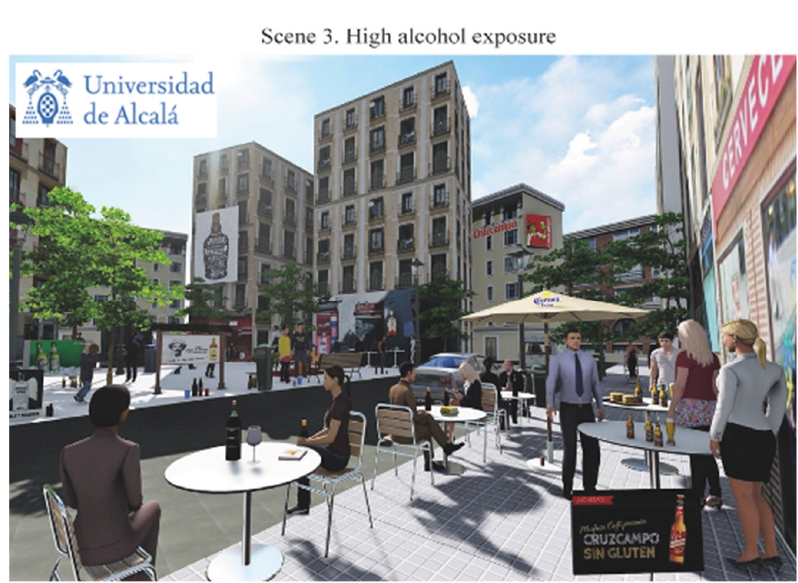
Figure 6. High alcohol exposure scenario.